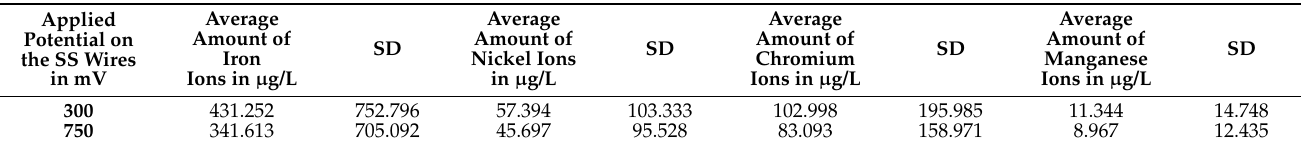
Table 12. The average amount of Fe, Ni, Cr, and Mn ions being measured when 300 mV or 750 mV was applied on the three different dimensions of the SS